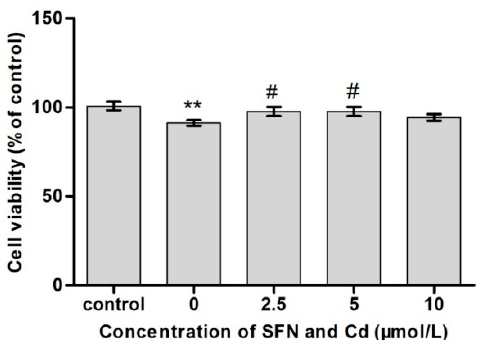
Figure 3. Influence of Cd and SFN on the survival of TM3 cells. The cells were treated with 0, 2.5, 5, and 10 µmol/L SFN and 10 µmol/L Cd. ** represent an extremely significant difference, compared with the control group. # represents a significant difference, compared with the Cd group.